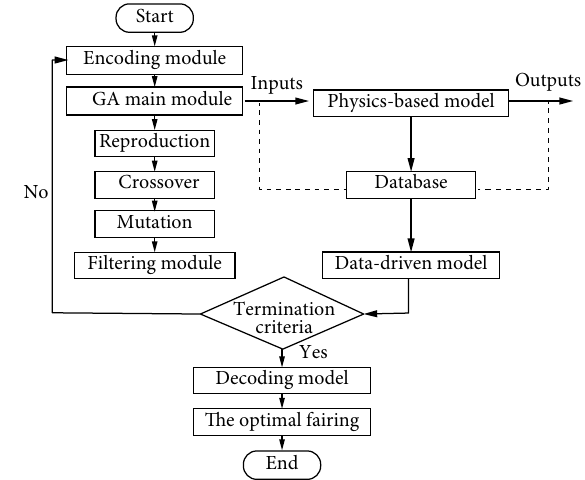
Fig. 5 Detailed solving process of